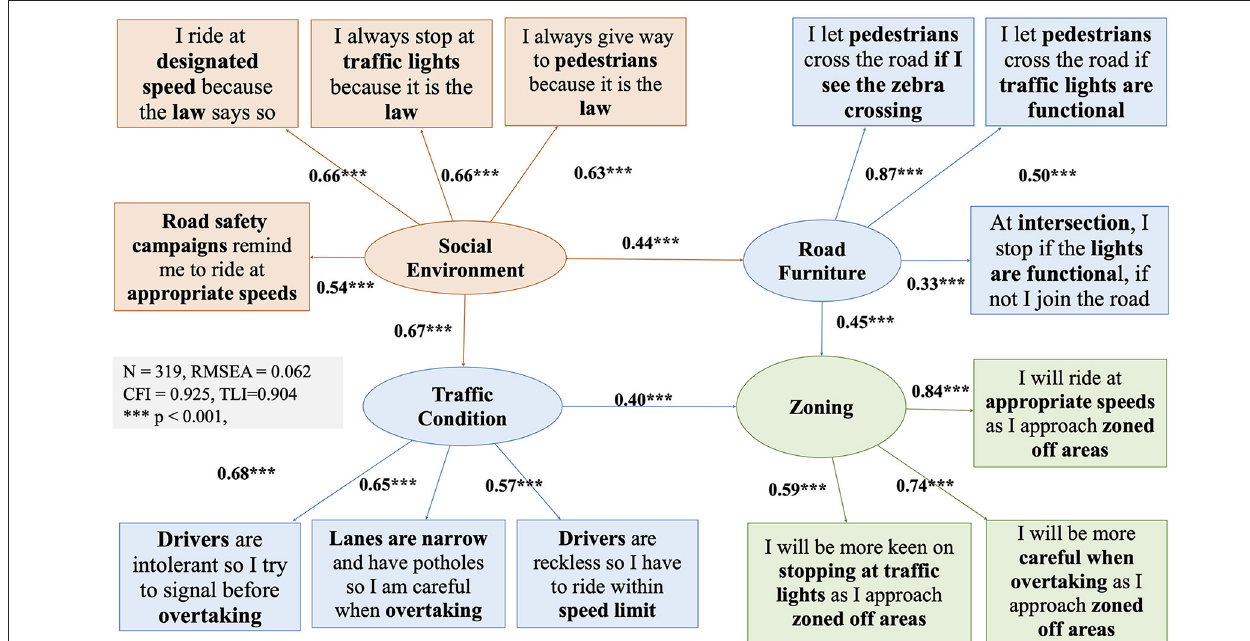
FIGURE 5 | Model 3—Speed and priority model.